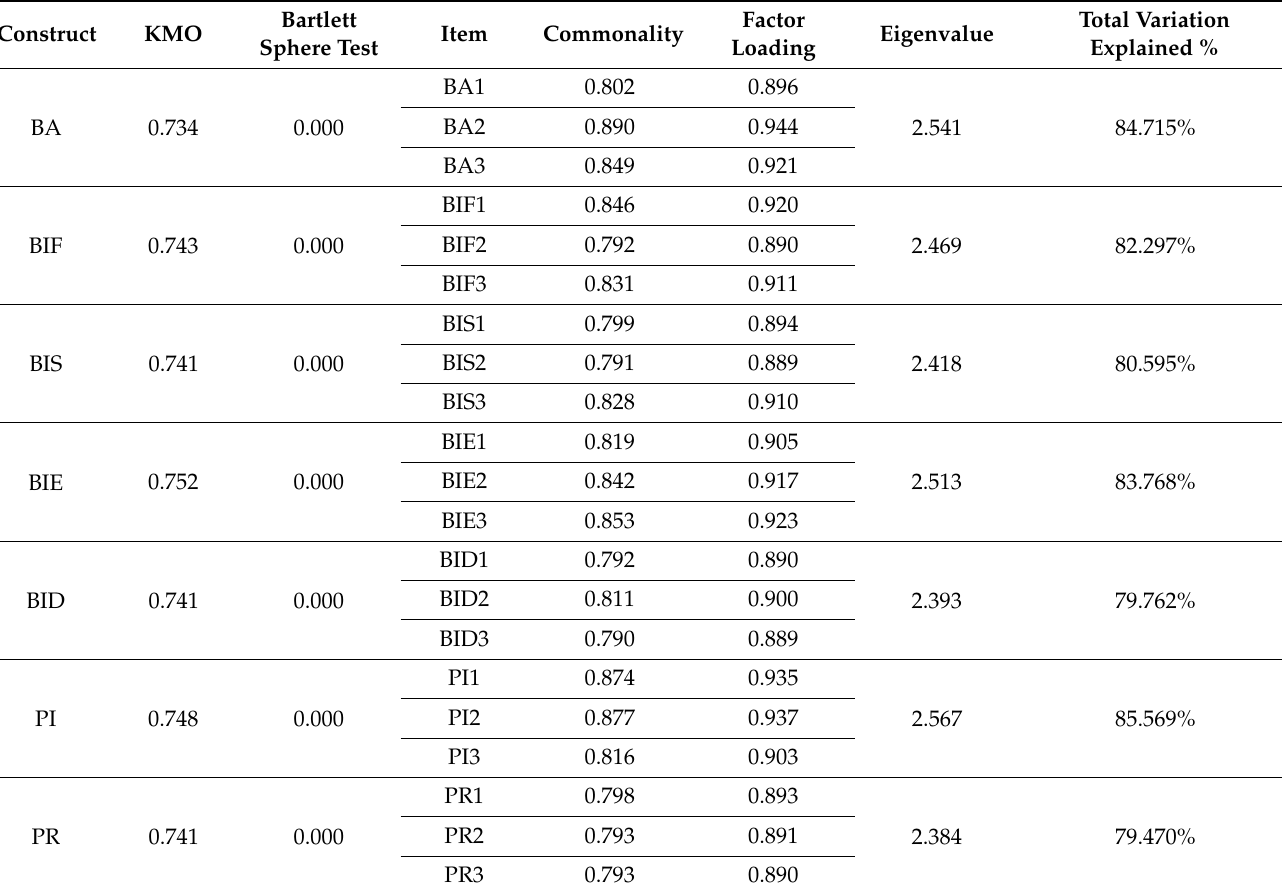
Table 5. The results of exploratory factor analysis.